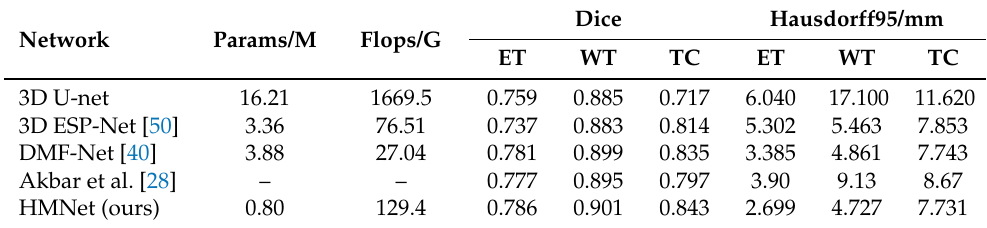
Table 9. Comparison with other brain tumor segmentation networks on the BraTS 2018 validation set. Here, (–) denotes that the results are not reported.